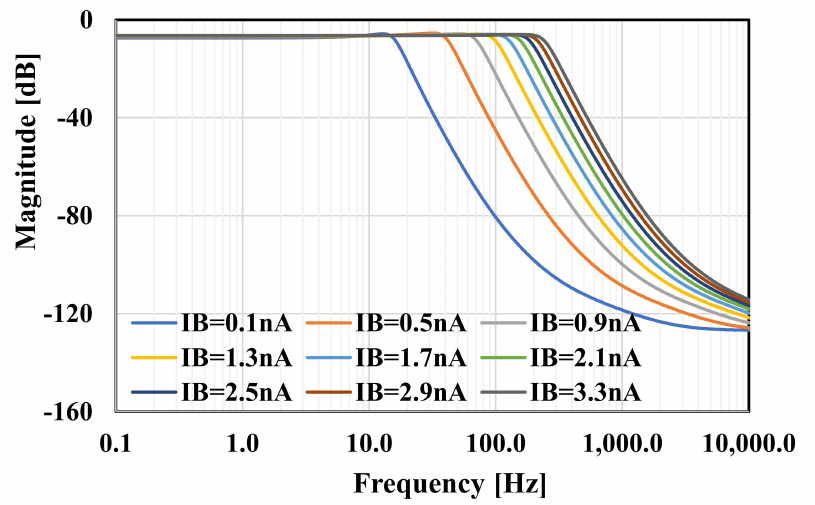
Figure 11. The frequency response of the proposed filter with di ff erent bias